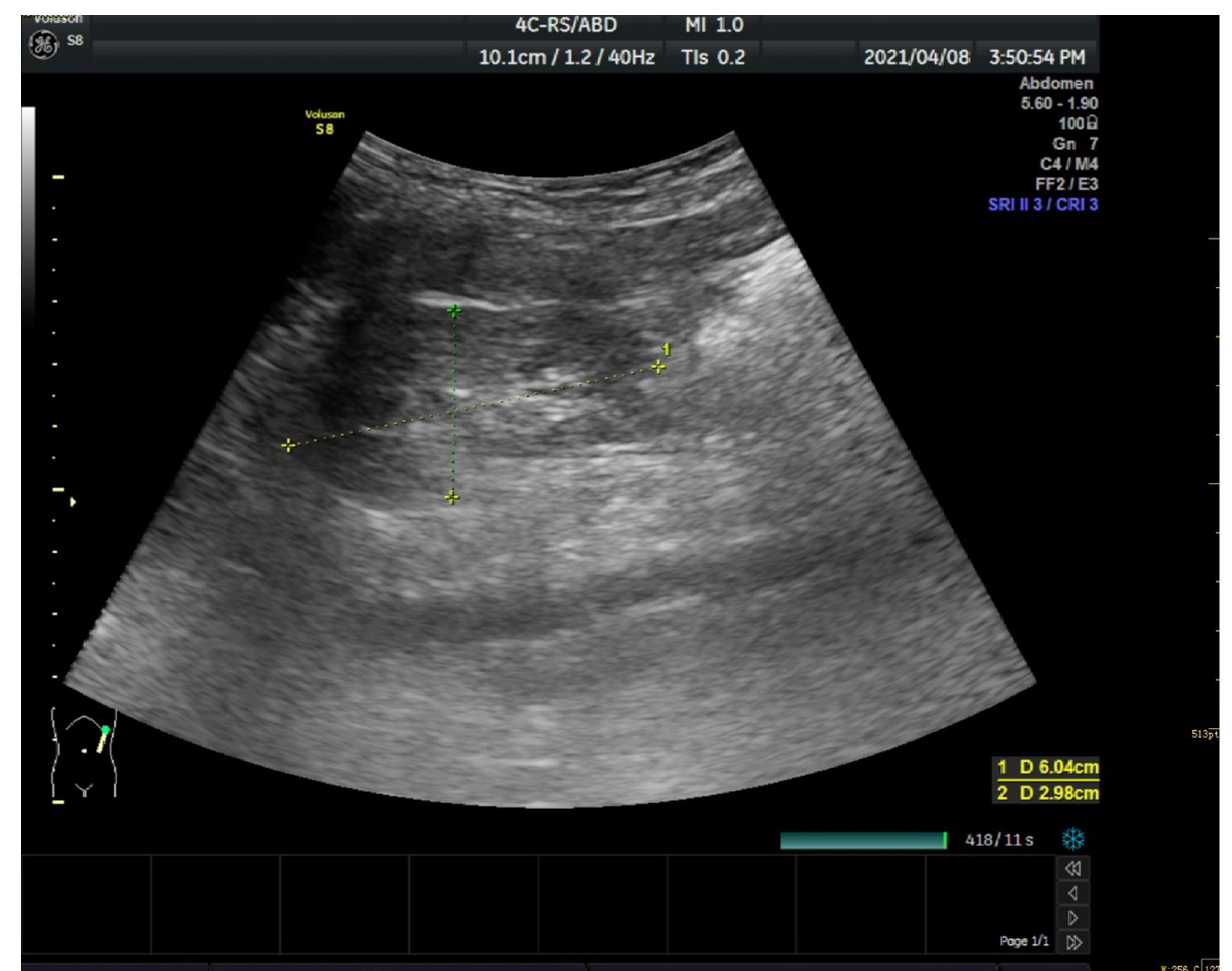
glycosylated hemoglobin and fasting blood glucose were